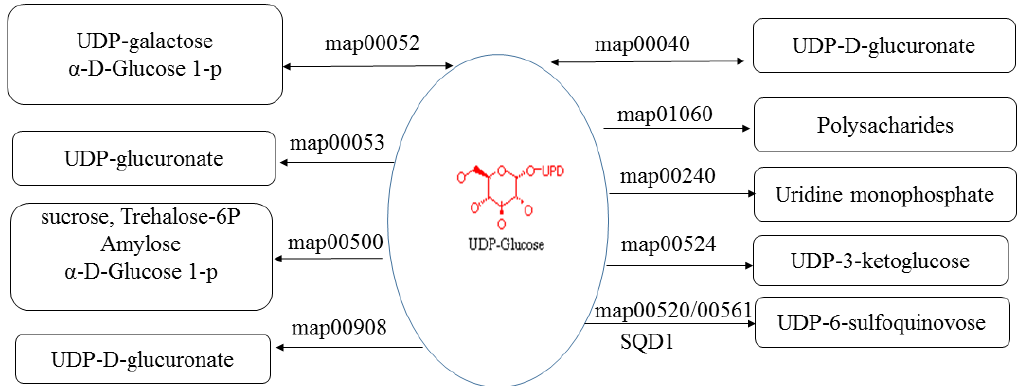
Figure 6. KEGG (Kyoto Encyclopedia of Genes and Genomes) pathways which UDP-glucose were involved in. map00052: Galactose metabolism; map00040: Pentose and glucuronate interconversions; map00053: Ascorbate and aldarate metabolism; map01060: Biosynthesis of plant secondary metabolites; map00240: Pyrimidine metabolism; map00500: Starch and sucrose metabolism; map00524: Neomycin, kanamycin and gentamicin biosynthesis; map00520: Amino sugar and nucleotide sugar metabolism; map00561: Glycerolipid metabolism; SQD1: UDP-sulfoquinovose